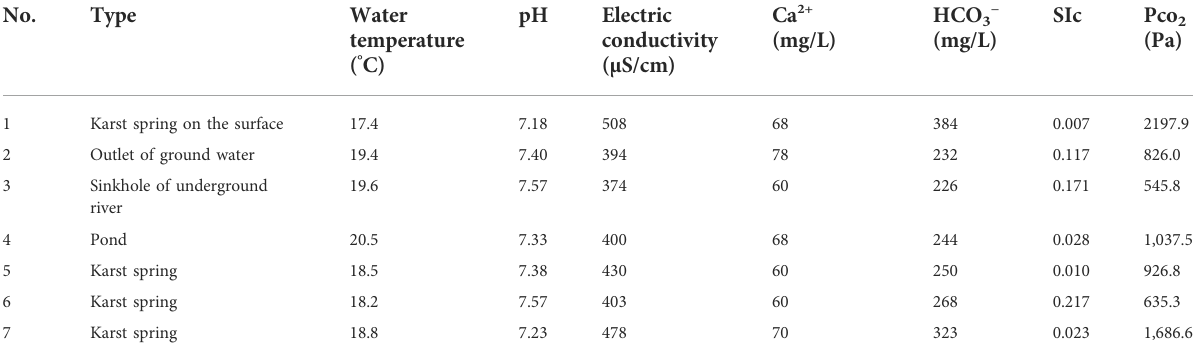
TABLE 2 Hydrochemical Parameters of Important Water Points of the Underground River Basin in Banzhai (The sampling positions are shown in Figure 5C).